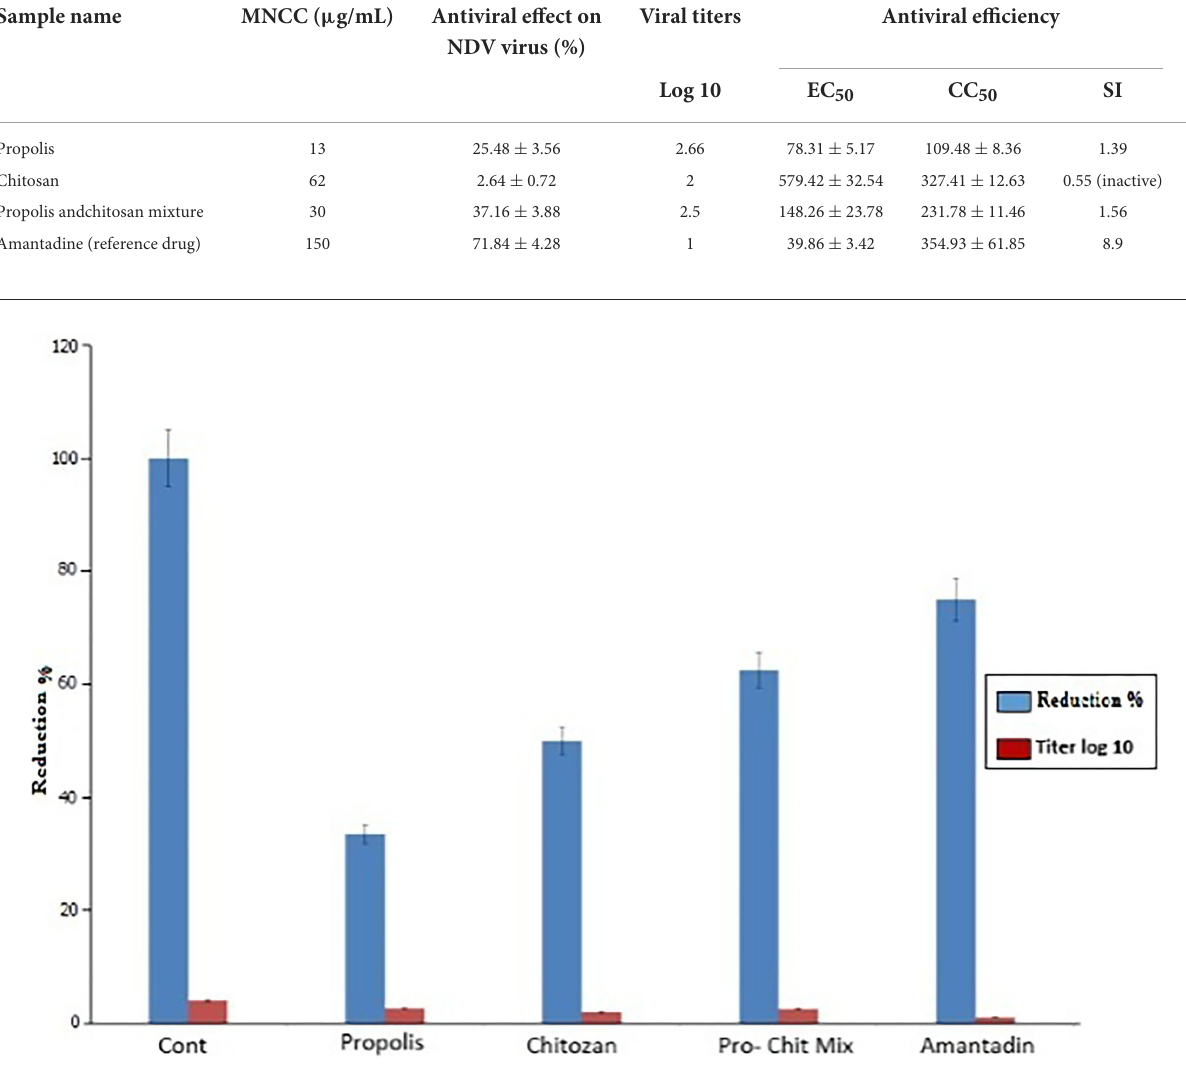
FIGURE6 Assessment of antiviral activity of propolis, chitosan, the propolis–chitosan mixture, and amantadine on the Newcastle disease virus titer by 50% tissue culture infectious dose (TCID50) assay ( p <